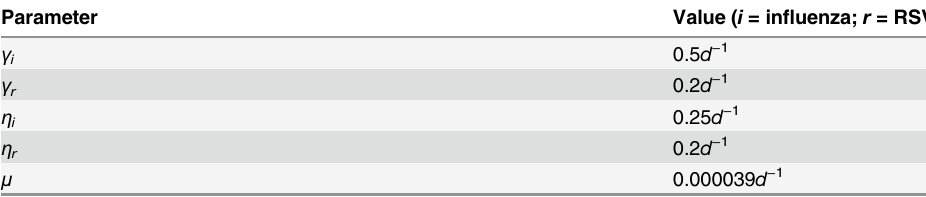
Table 1. The incubation and infection recovery rates for influenza and RSV [36]. Parameter